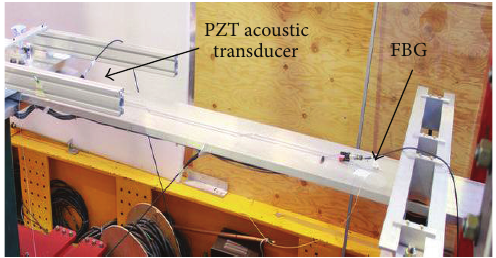
Figure 25: Generation and detection of acoustic waves in a 25.4 mm thick aluminum